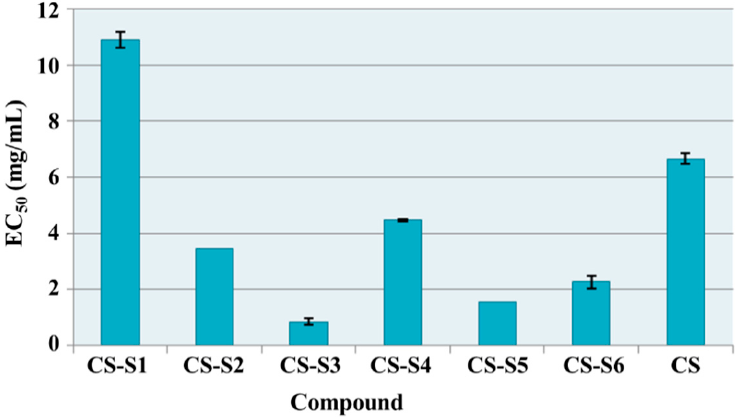
Figure 9. Ferric reducing power (EC 50 mg/mL) of chitosan derivatives.